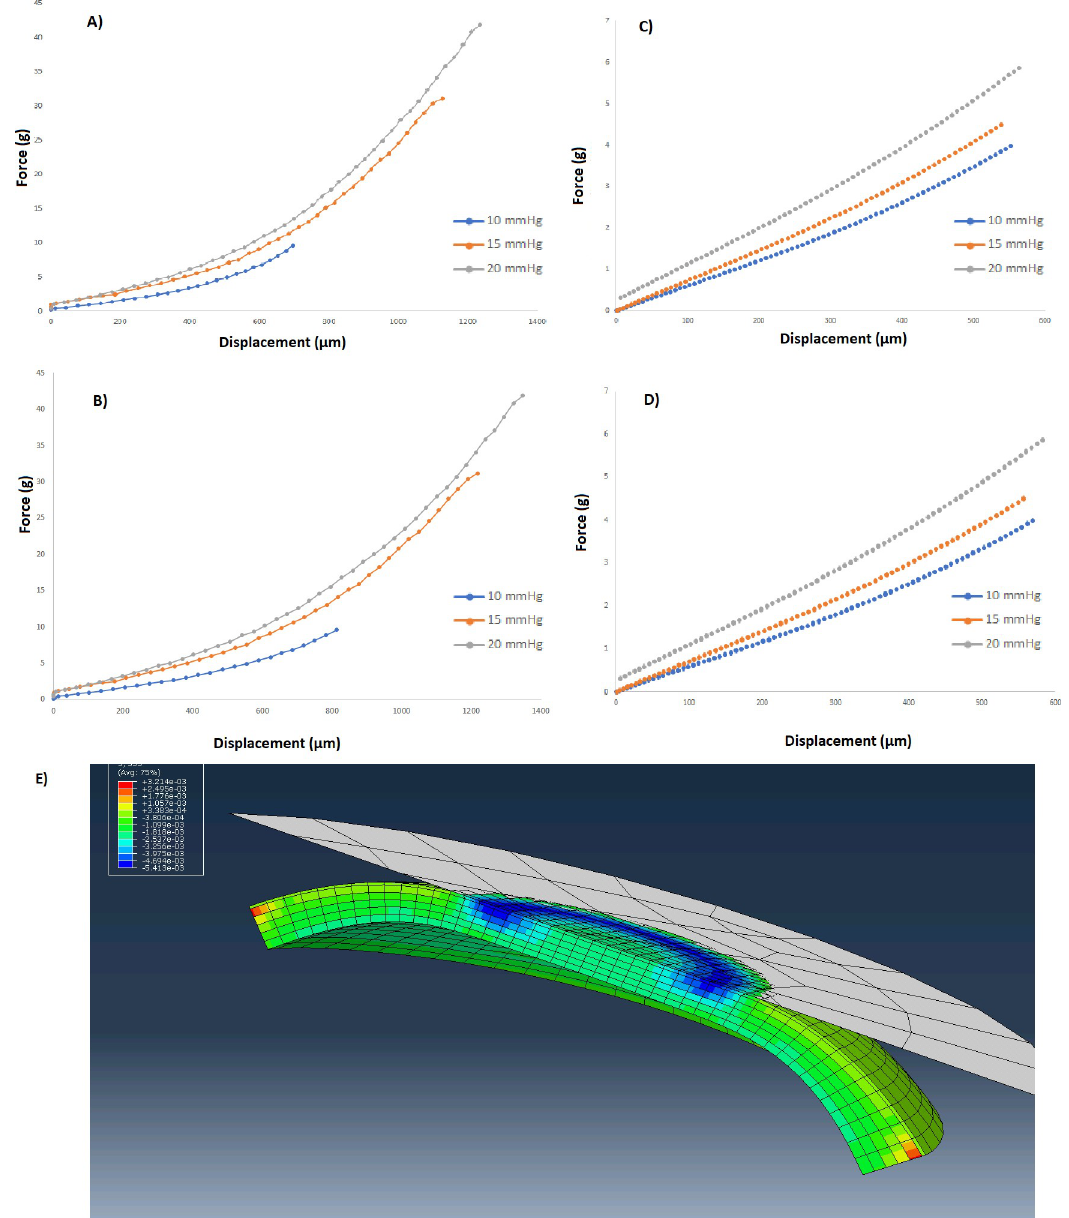
Fig 4. System sensitivity to the intra-eye IOP variability. Anterior (A), and posterior (B) force/displacement curves from donor eye experiment with IOP values of 10, 15, and 20 mmHg. Anterior (C) and posterior (D) force/displacement curves from in silico experiment with 10, 15, and 20 mmHg IOPs. E: Axial corneal stresses under compression from in-silico study at IOP =